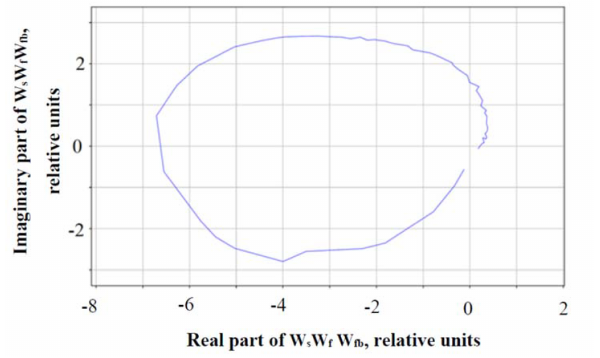
Figure 10. Pressure variations at the 24Hz signal. Red is the MET hydrophone signal spectrum, and blue is the ZETLab BC-311 hy- drophone signal spectrum. Hz on the x axis, counts of DAS on the y axis.